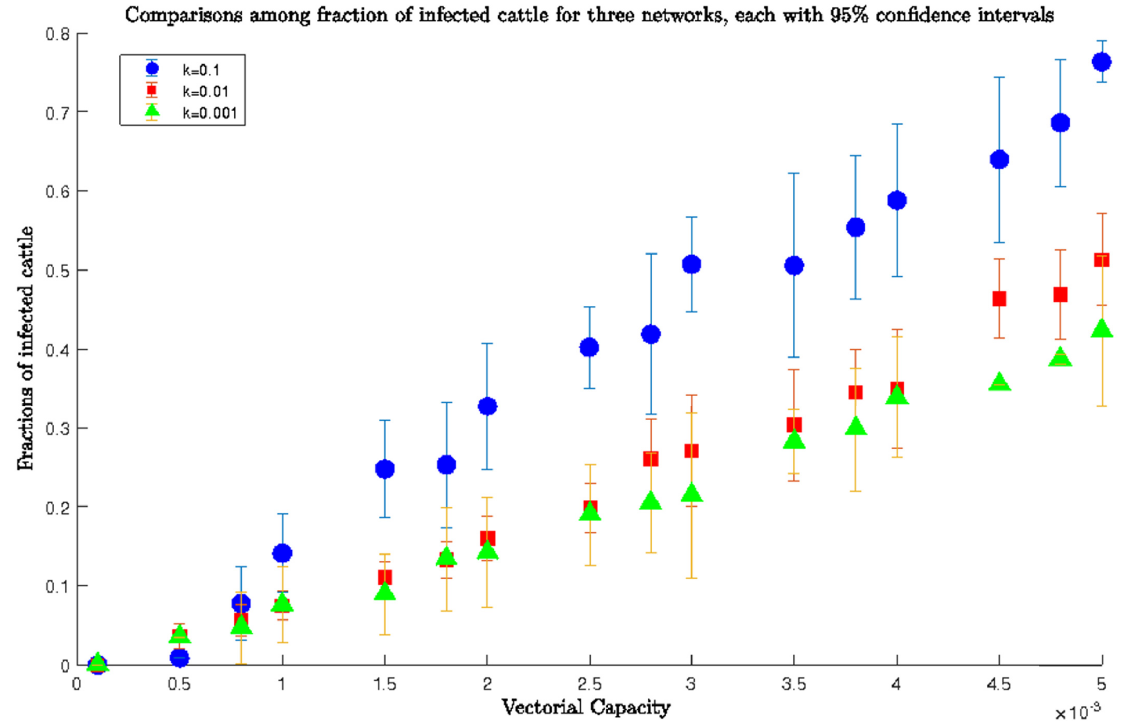
Fig 6. Comparisons among fractions of infected cows for heterogeneous network for three different values of k and lower range of β ; for k = 0.001 and 0.01, the maximum fraction of infected cows was less than 0.5 for the highest value of transmission rate in the lower range, which meant after the simulation period half of the cows became infected. However, for k = 0.1, the infected cows reached up to 0.8. Therefore, we needed to reduce the value of k i.e., cattle movement, to reduce the fraction of infected